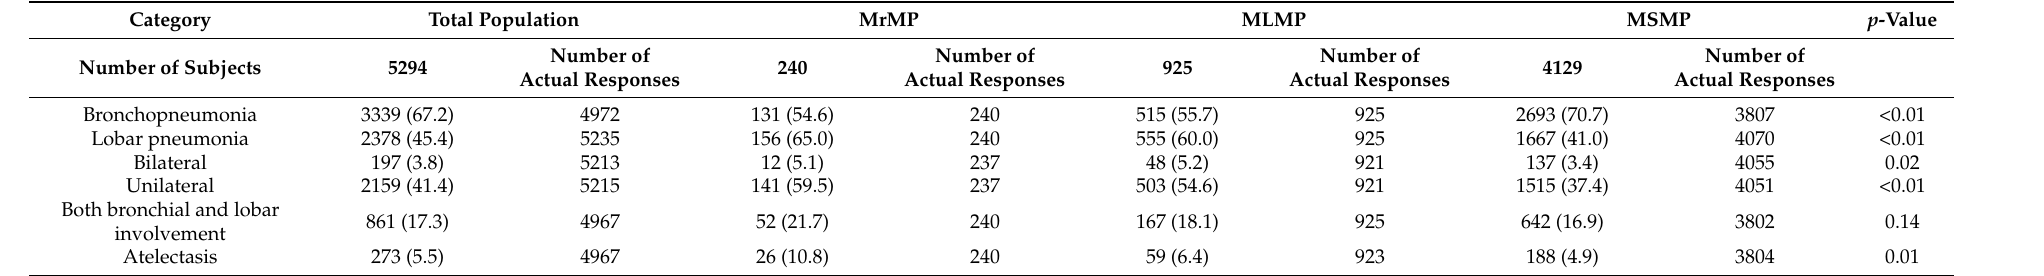
Table 4. Initial chest imaging findings in Mycoplasma pneumoniae pneumonia patients.